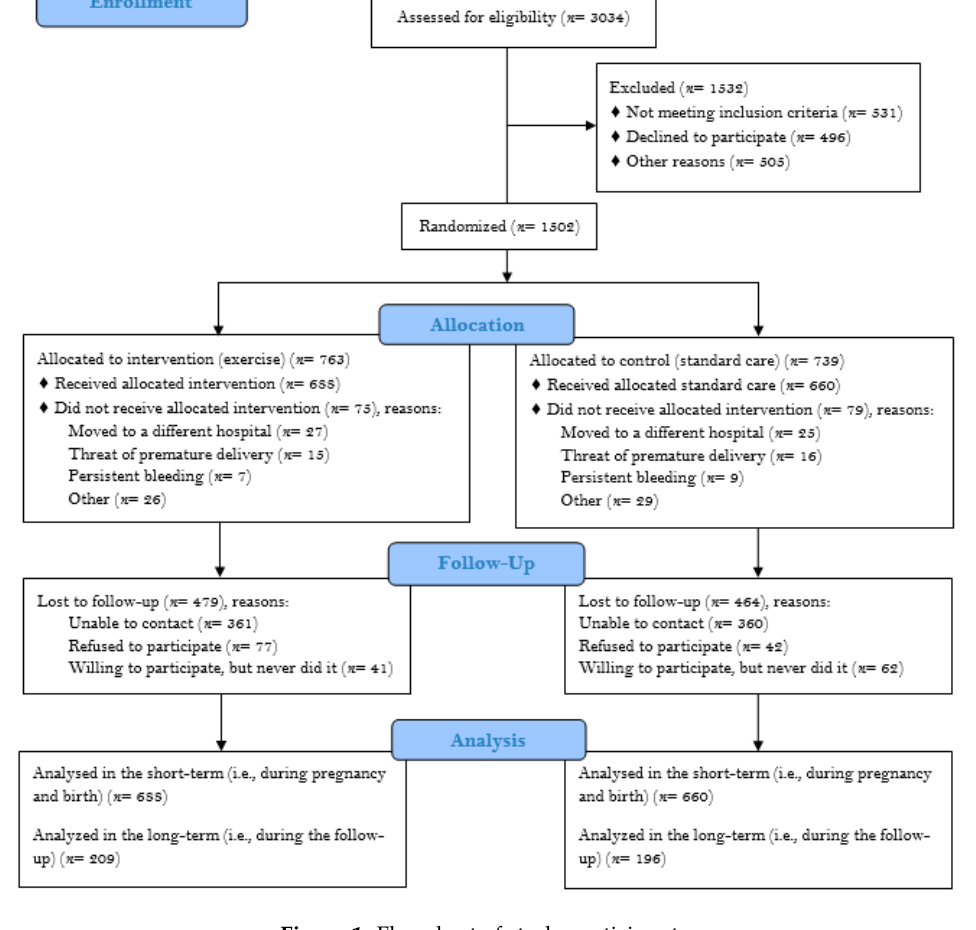
Figure 1. Flowchart of study participants. Table 1. Participants’ baseline characteristics in the intervention (exercise) and control groups.